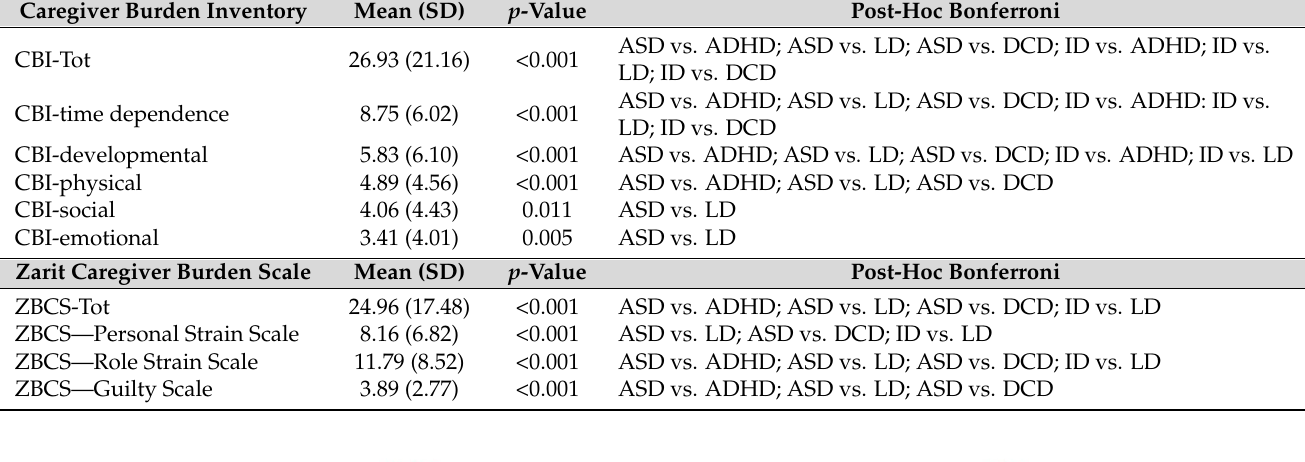
Table 3. Univariate ANOVA for the scores and subscores of the two questionnaires (in the 5 subgroups of caregivers).